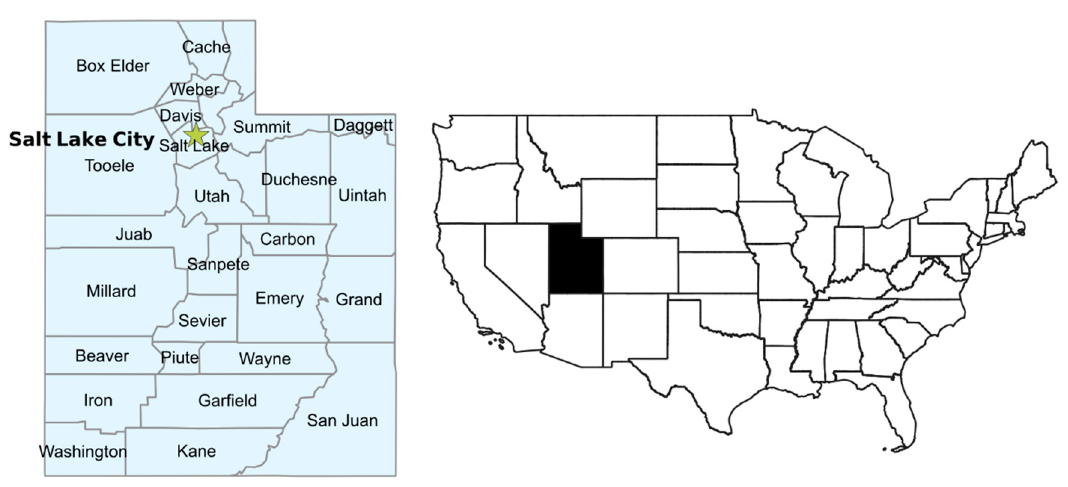
Figure 1. Map of the state of Utah showing county boundaries ( left ) and context within wider USA ( right ).